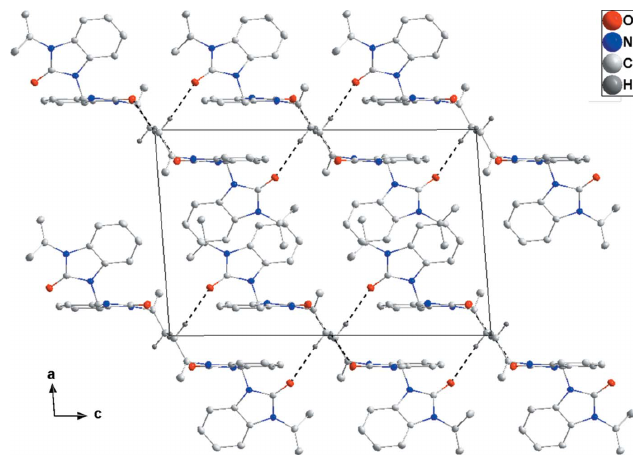
Figure 2 The packing viewed along the b -axis direction giving an elevation view of two adjacent layers. Intermolecular C—H (cid:2)(cid:2)(cid:2) O hydrogen bonds are shown as dashed lines.